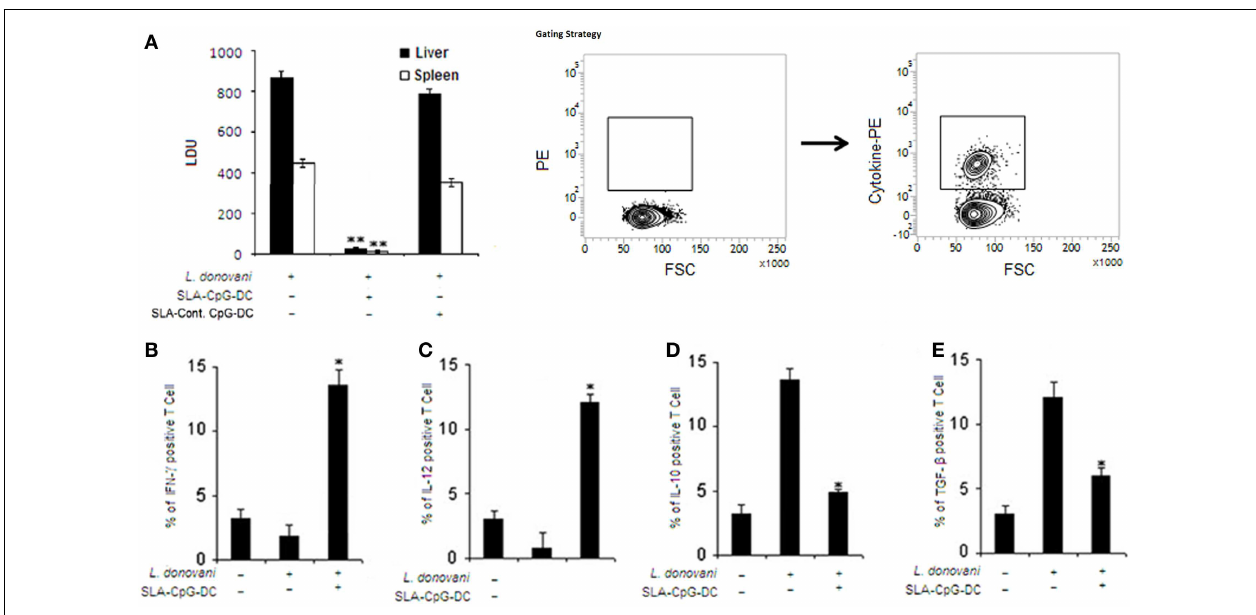
PBS-treated infected mice. In another set of experiments, splenocytes (2 × 10 6 ) from control, L. donovani -infected (28days), and SLA–CpG–DC-vaccinated infected mice (28days) were assessed for intracellular (B) IFN- γ , (C) IL-12, (D) IL-10, or (E) TGF- β staining, which was performed as mentioned in Section “Materials and Methods” and analyzed by flow cytometry. Magnetically purified CD4 + T cells were analyzed for IL-12-PE, IFN- γ -PE, IL-10-PE, orTGF- β -PE staining to detect CD4 + IL-12 + , CD4 + IFN- γ + , CD4 + IL-10 + , or CD4 + TGF- β + T cells.The bar graphs represent the mean dot plot values based on the region encircling positive cells from three independent experiments * P < 0.05, compared with infected sets.The error bars represent mean ± SD of three mice per